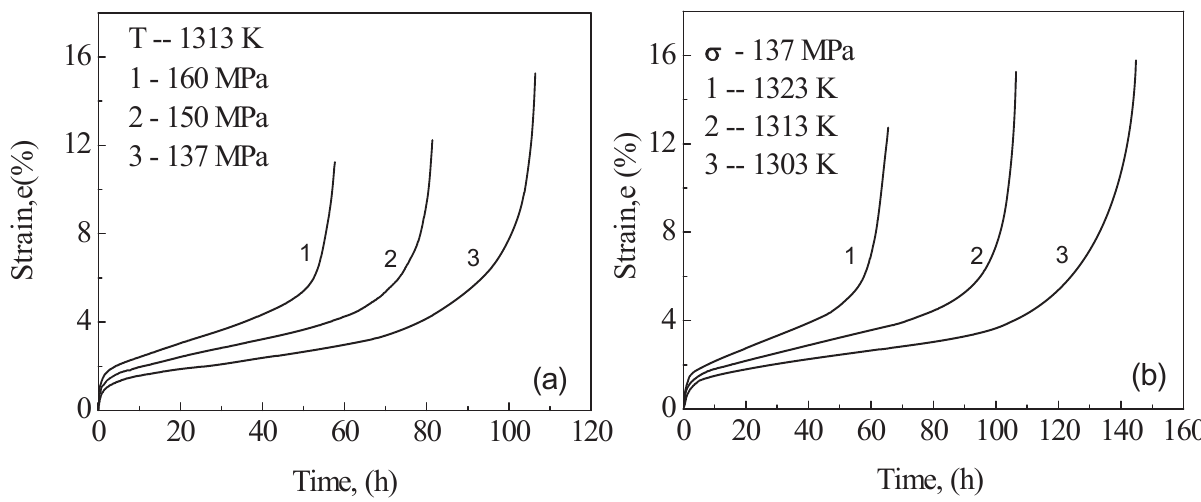
Figure 4. Creep curves of the alloy 2 under different conditions. (a) Applied different stress at 1313 K, (b) applied stress of 137 MPa at different